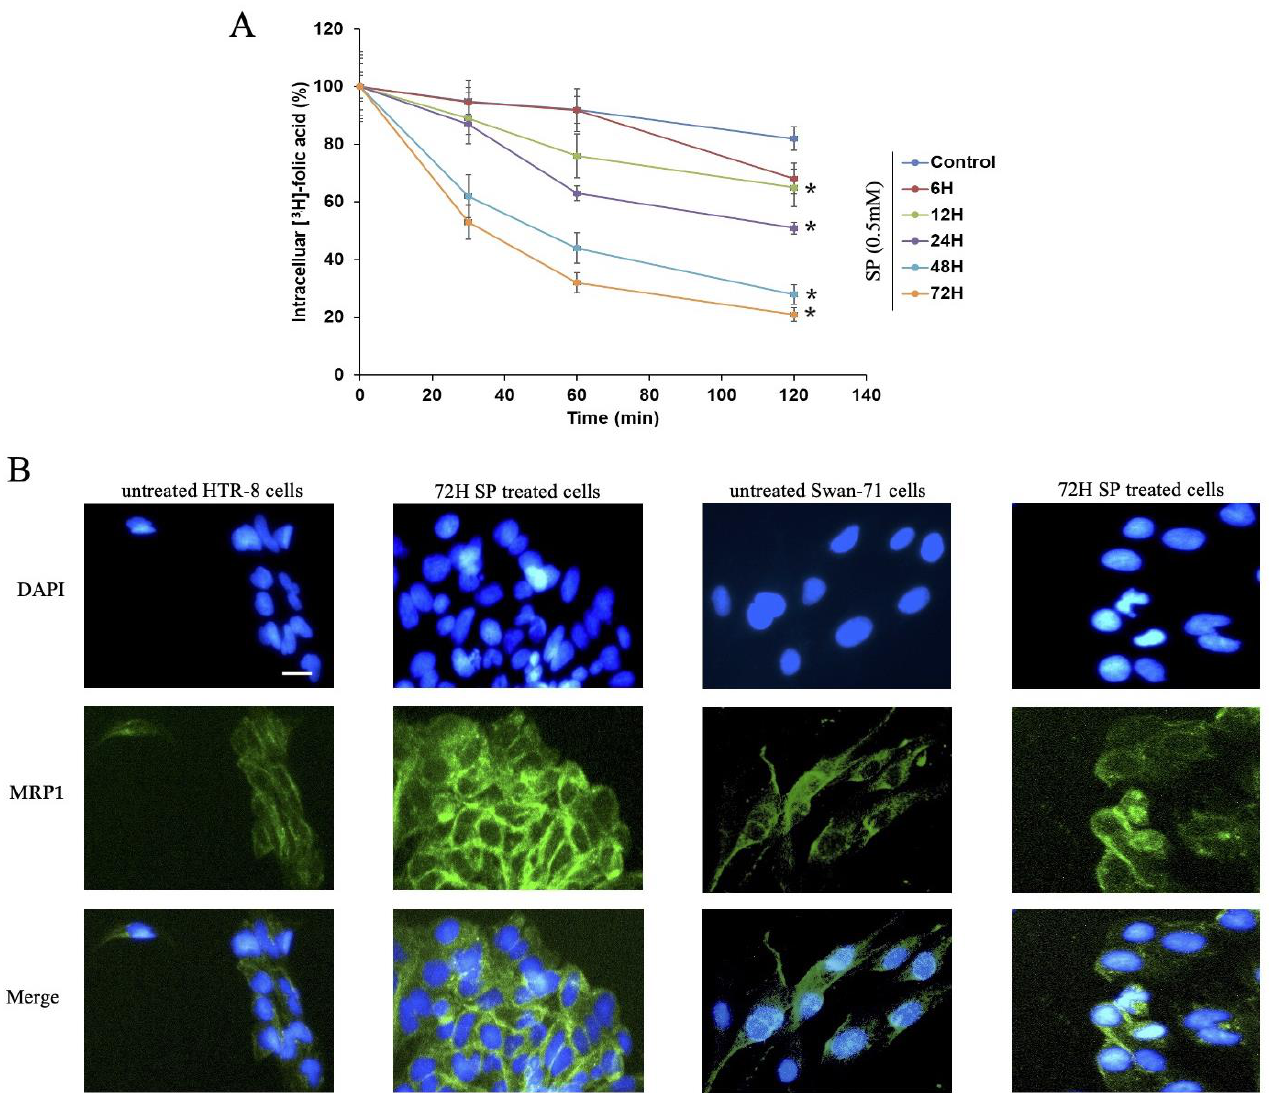
Figure 2. Effect of palmitic acid on [ 3 H]-folate efflux and localization of MRP1 in HTR8/SVneo cells. ( A ) Effect of length of exposure to 0.5 mM palmitic acid (0, 6, 12, 24, 48, and 72 h) on [ 3 H]-folate efflux in HTR8/SVneo cells. Cell lysates were measured for radioactivity at 0, 30, 60, and 120 min. Mean values were obtained from three independent experiments and error bars indicate SD. * p < 0.05 compared to controls. ( B ) MRP1 expression in HTR8/SVneo and Swan-71 cells after treatment with palmitic acid at 0 and 72 h determined by immunofluorescence. Nuclei were stained with DAPI and MRP1 was stained with Alexa Fluor 488. Images have been merged using Photoshop software.